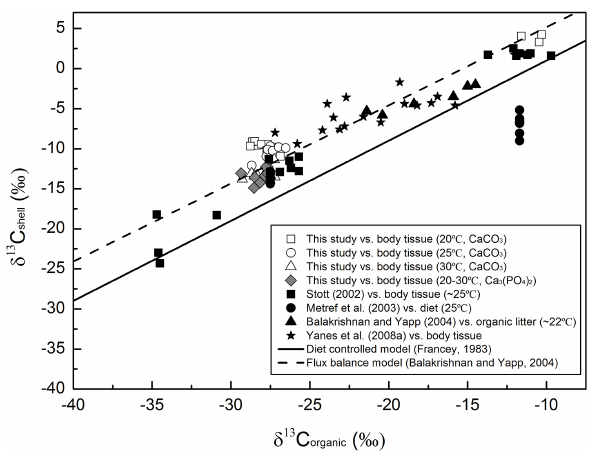
Figure 3. Measured δ 13 C of snail shell aragonite against δ 13 C of associated organic matter (This study; Stott, 2002; Metref et al., 2003; Balakrishnan and Yapp, 2004).